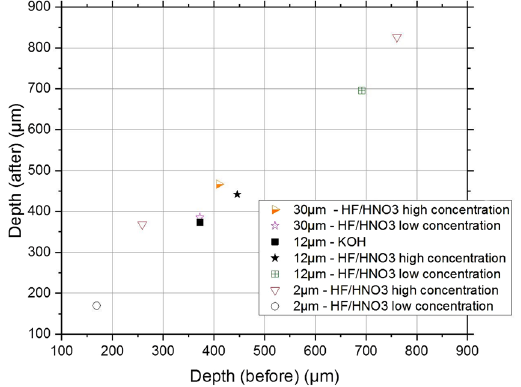
Figure 4. Scratch depth before and after etching. Wet etching is conducted with different etching solutions using various concentrations of HF/HNO 3 and KOH and different material